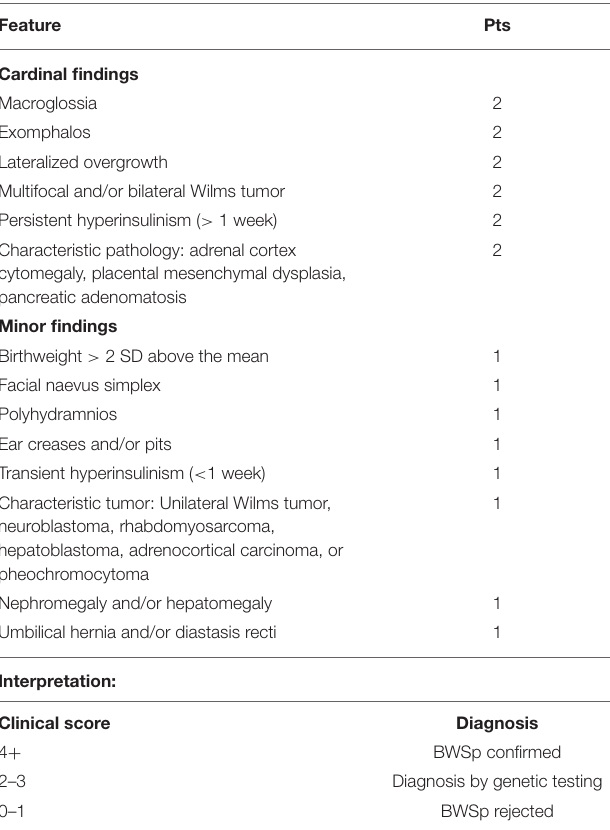
TABLE 1 | Clinical diagnostic criteria for Beckwith–Wiedemann